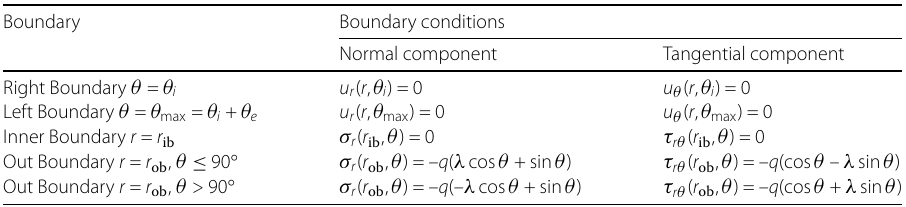
Table 1 Boundary conditions of the computational model Boundary Boundary conditions